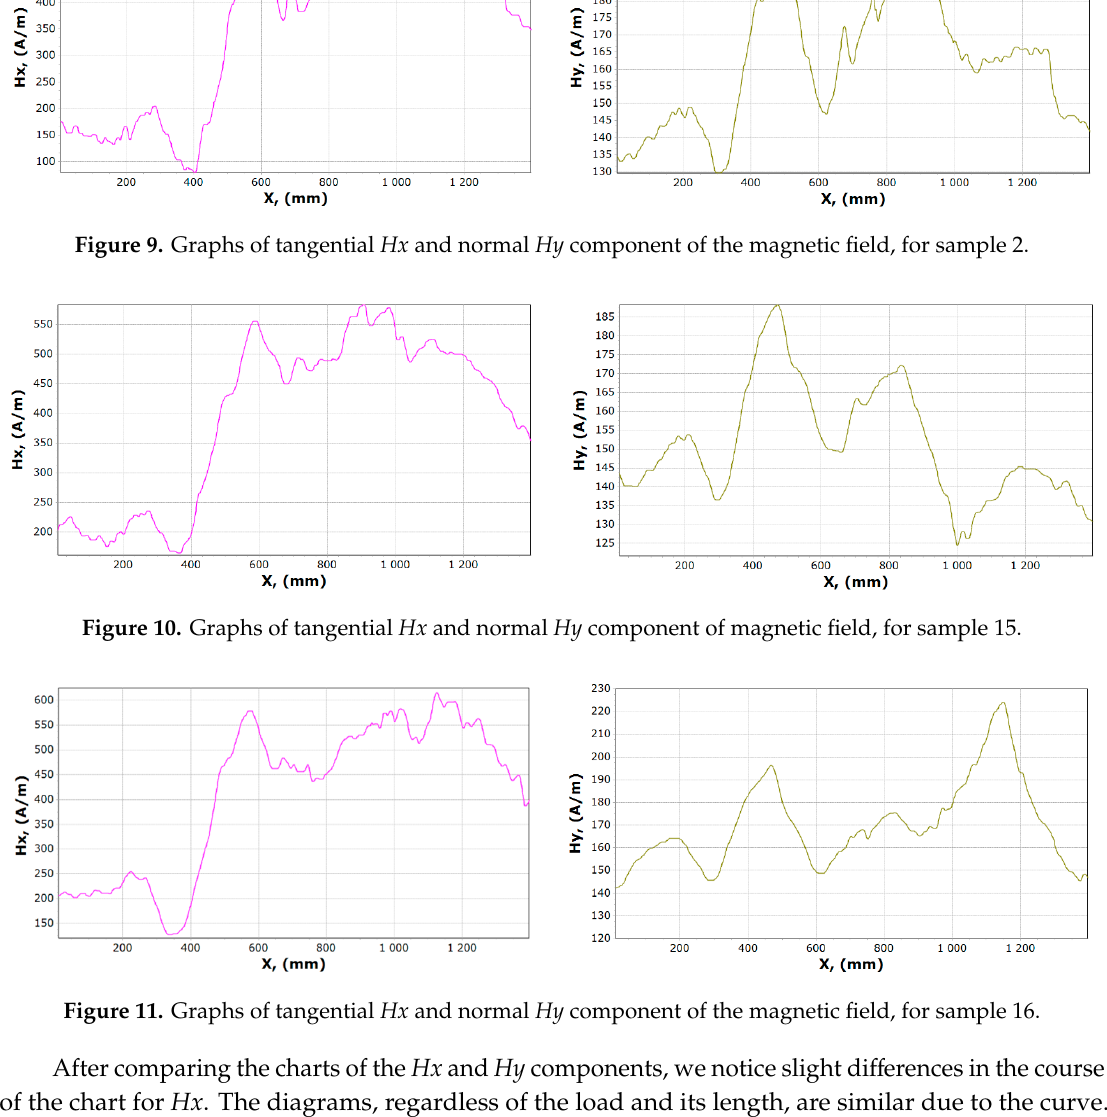
Figure 8. Graphs of tangential Hx and normal Hy component of the magnetic field, for sample 1.